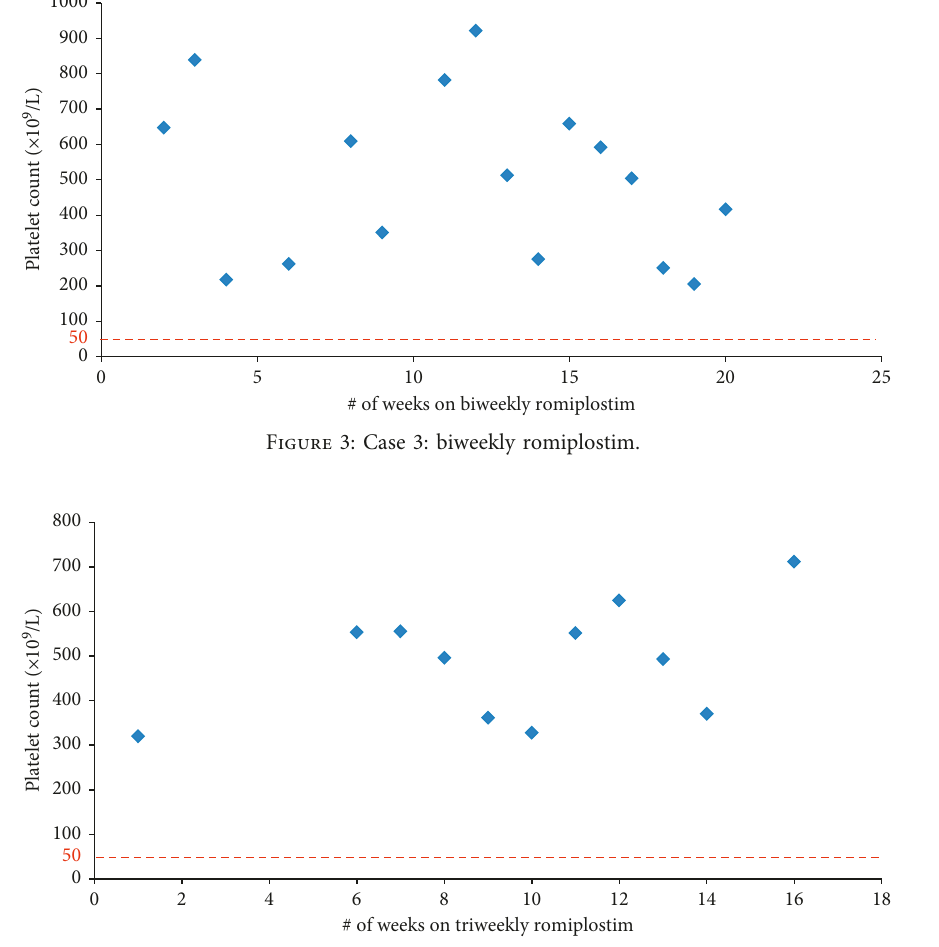
Figure 4: Case 3: triweekly romiplostim.